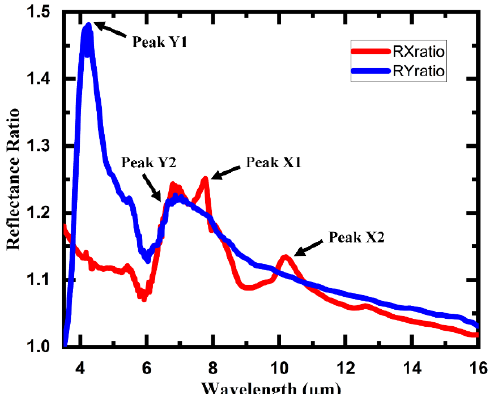
Figure 10. The reflectance ratio spectra of the 3D meta-atom array for the incident light with different polarized directions. RXratio and RYratio describe how much the reflectance of smaller claw gap array (Array2) varies with respect to that of larger claw gap array (Array1) under IR incident light with linear polarization direction of X-axis and Y-axis, respectively.